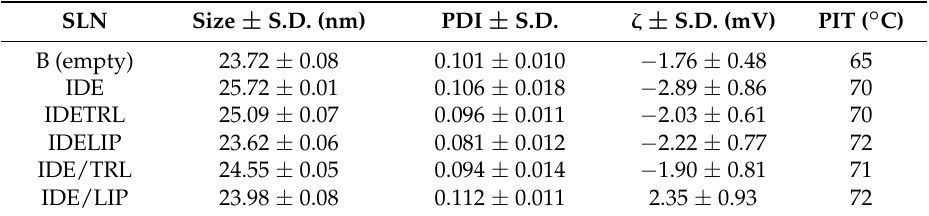
Table 1. Mean size (size), polydispersity index (PDI), zeta potential ( ζ ), and phase inversion temperature (PIT) of unloaded and drug loaded SLN. SLN Size ± S.D.